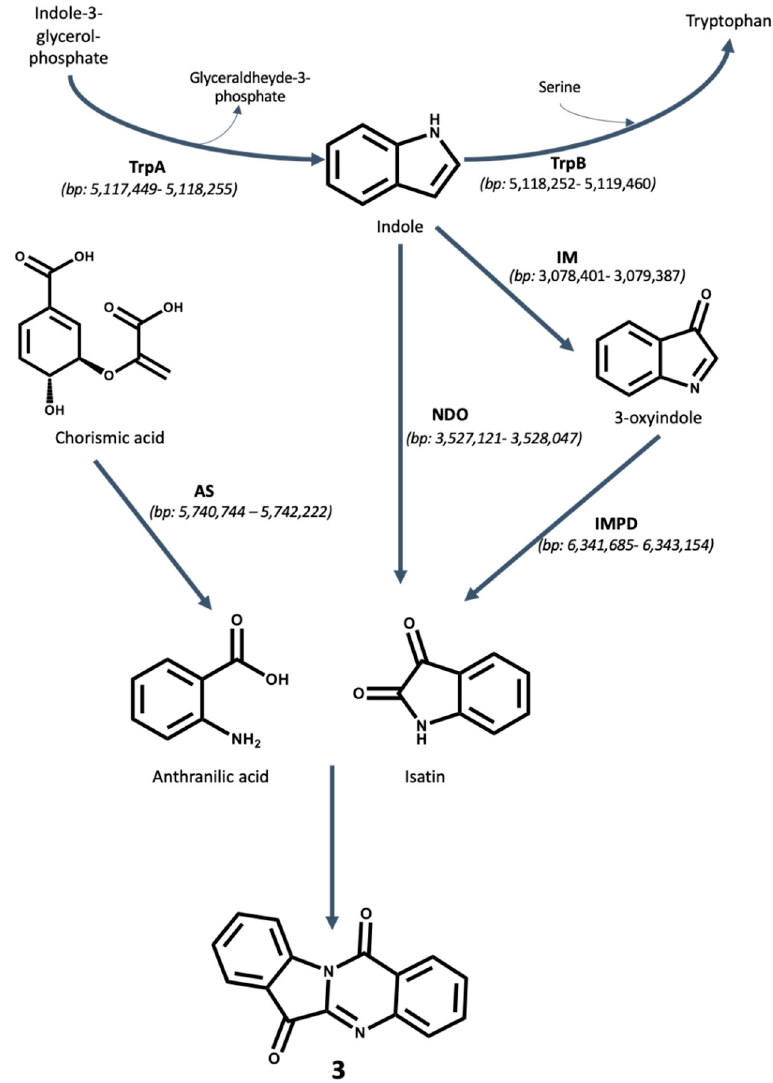
Figure 3. Proposed biosynthesis mechanism for tryptanthrin by P. aeruginosa UWI ‐ 1. Indole is proposed to originate from tryptophan degradation via an unclassified carbon–carbon lyase. Indole is oxygenated either into 3 ‐ oxyindole by indole monooxygenases (IM) and then further oxygenated by inosine 5 ‐ monophosphate dehydrogenase (IMPD) into isatin. In another route, indole may be converted directly to isatin via naphthalene 1,2 ‐ dioxygenase (NDO). Anthranilic acid is obtained through conversion of chorismic acid by the action of anthranilate synthase (AS). Both isatin and anthranilic acid fuse to form tryptanthrin. The location of each gene involved in the biosynthesis is given in parentheses and is based on the genome of P. aeruginosa UWI ‐ 1 available from the European Nucleotide Archive (ENA) project number PRJEB32405 (https://www.ebi.ac.uk/ena/data/view/PRJEB32405).